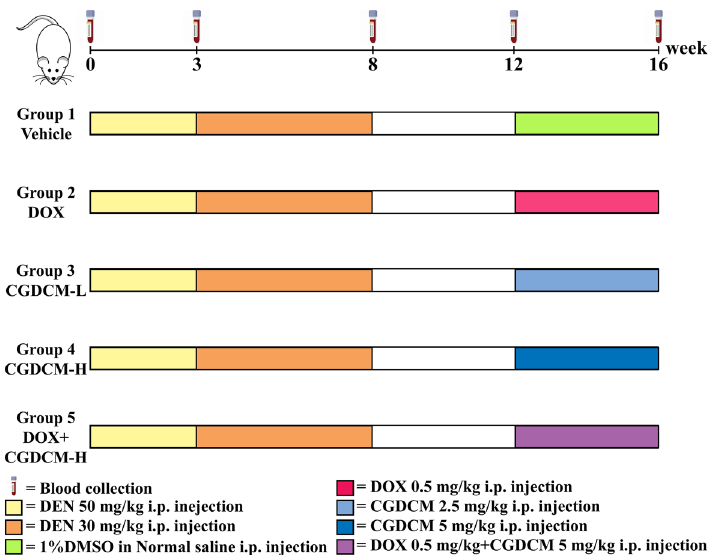
Figure 6. Experimental design of DEN-induced liver cancer rats. DEN administration was IP injected at a dose of 50 mg/kg twice a week for 3 weeks and then injected with a dose of 30 mg/kg twice a week for another 5 weeks until week 8. Then, DEN injection was stopped for 4 weeks (week 8 to week 12). The treatments were performed for 4 weeks from week 12. Randomization groups included DOX, CGDCM-L, CGDCM-H, and the combination of DOX with CGDCM-H. The vehicle group was treated with 0.8% DMSO. CGDCM, C. gigantea dichloromethane extract; CGDCM-L, CGDCM low dose; CGDCM-H, CGDCM high dose; DOX,